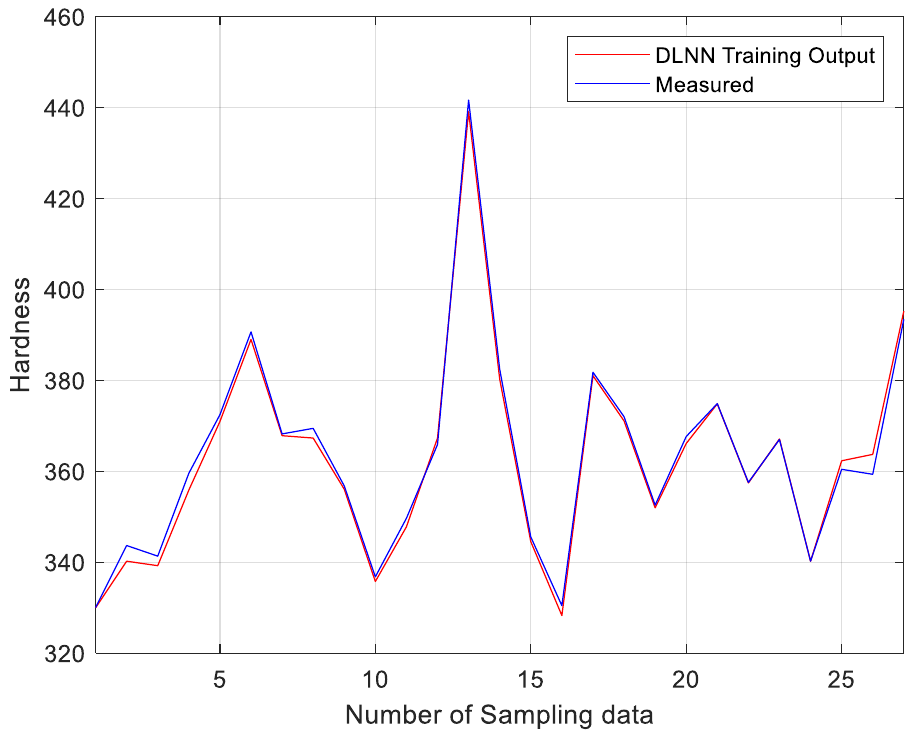
Figure 7. Measured hardness compared to the output of the DLNN model.